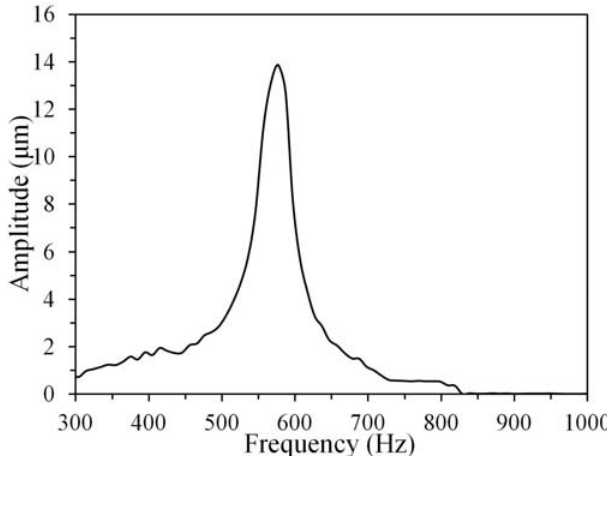
Figure 6. The measured dynamic response of the